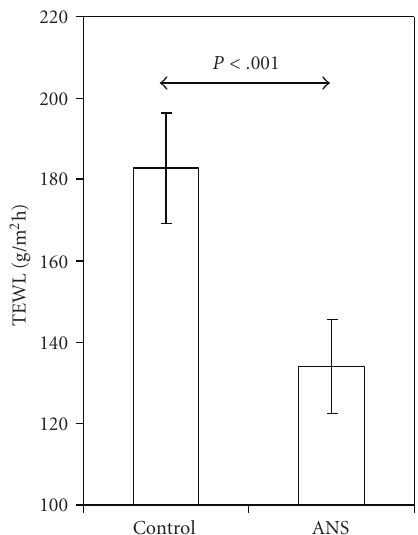
Figure 1: Transepidermal water loss (TEWL) is lower in embryonic day 18 rat pups exposed to antenatal corticosteroids (ANSs; n = 10) than in unexposed controls (Control; n = 15). Values are presented as means ±